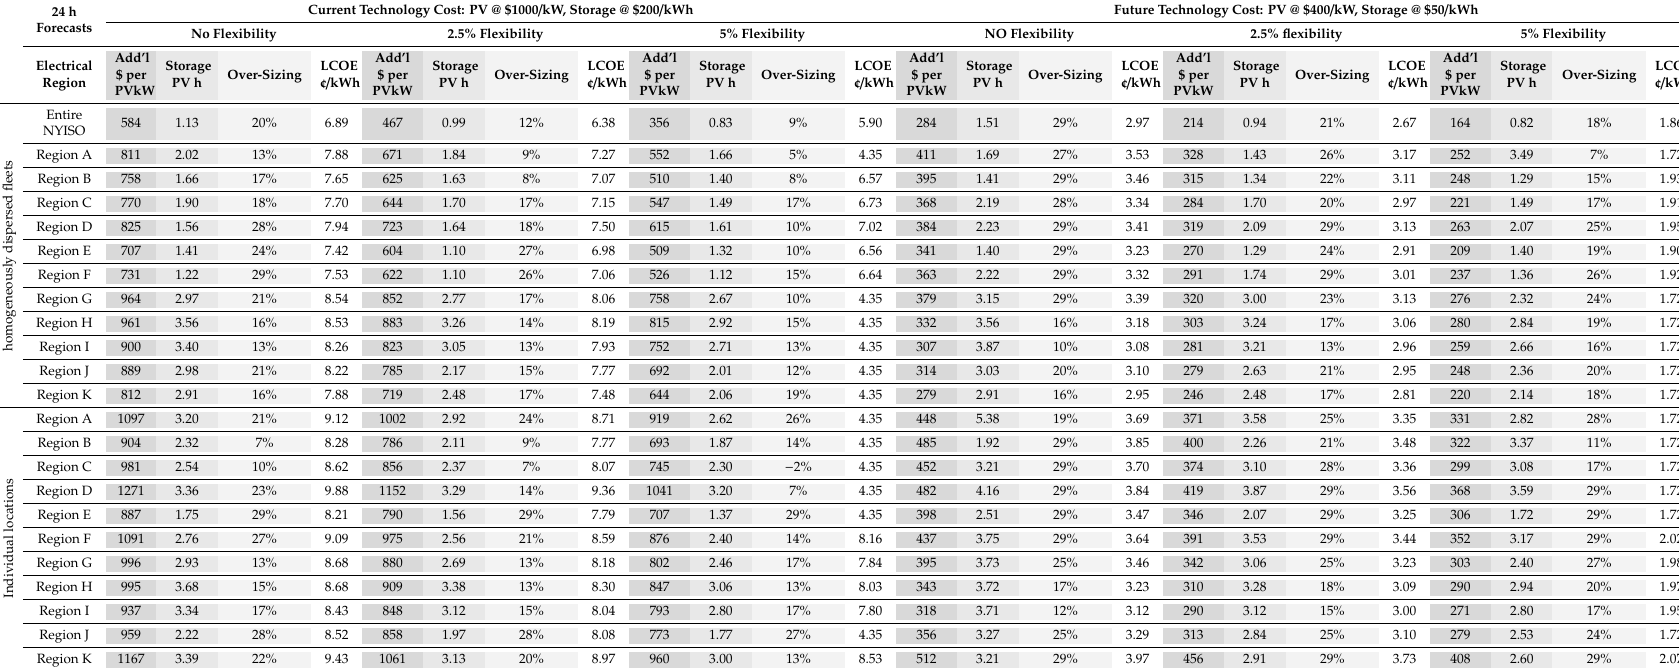
Table A8. Twenty-four-hours-ahead firm forecast results applying